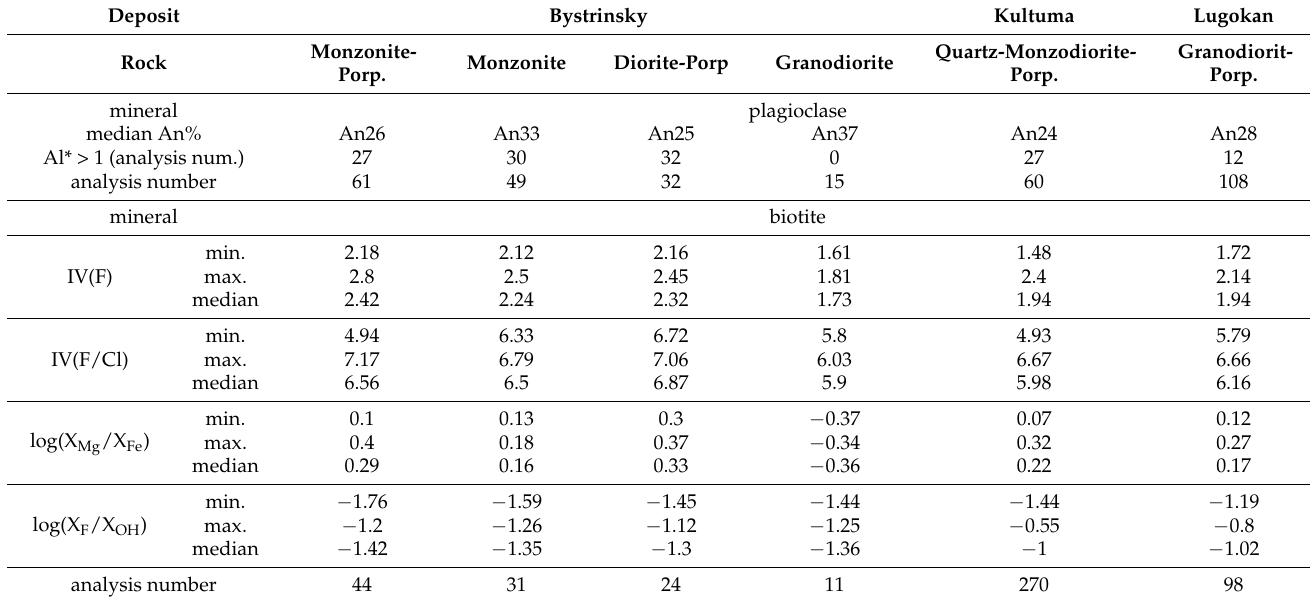
Table 1. The main characteristics obtained from the plagioclase and biotite geochemistry.